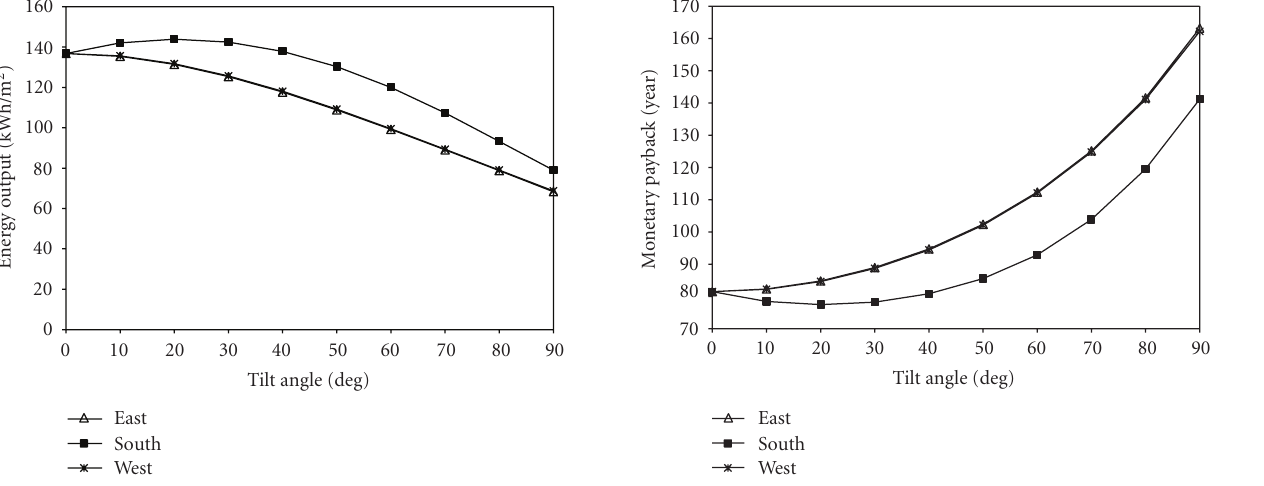
Figure 9: Annual PV energy output for various tilt angles and ori- entations.